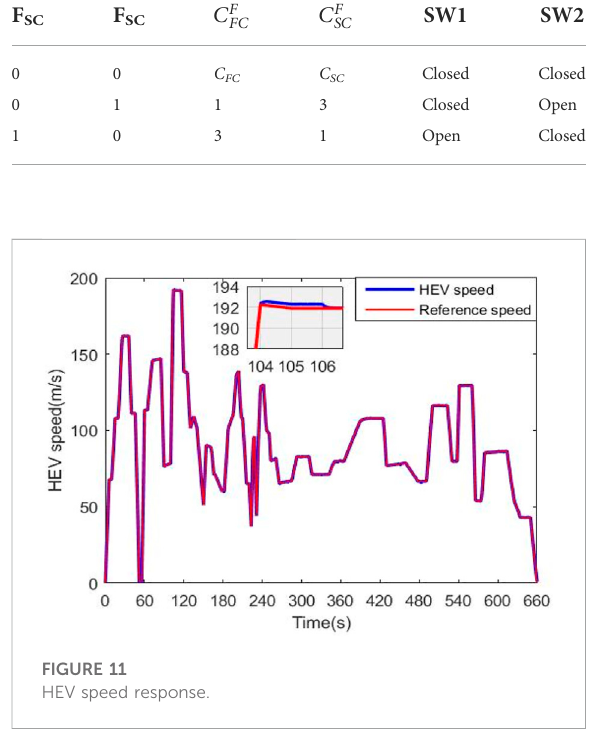
FIGURE 11 HEV speed response.